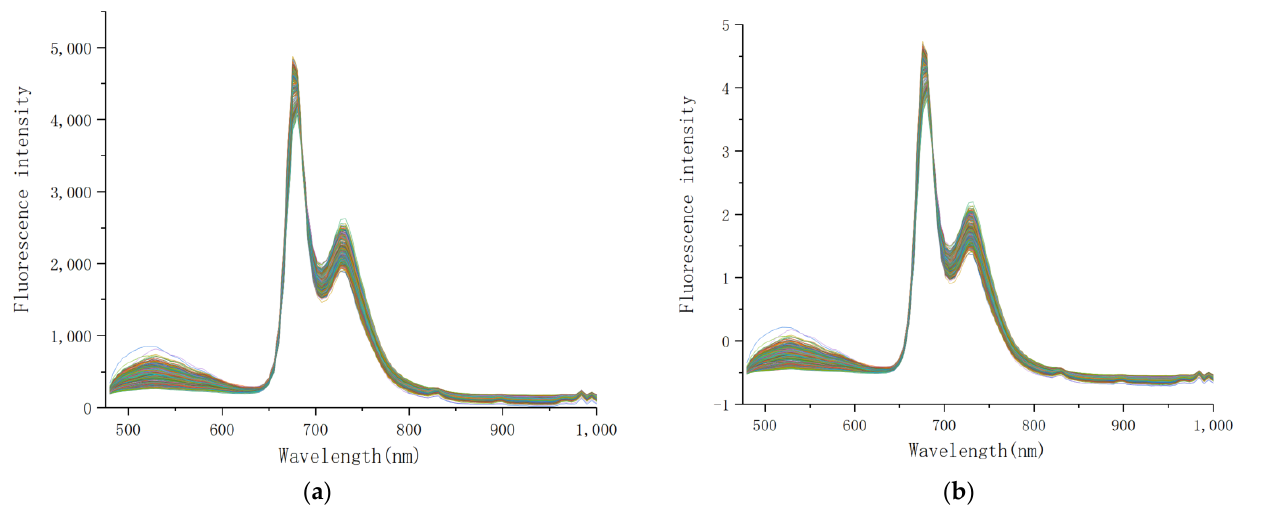
Figure 7. Two preprocessing methods. ( a ) Spectra after MSC; ( b ) Spectra after